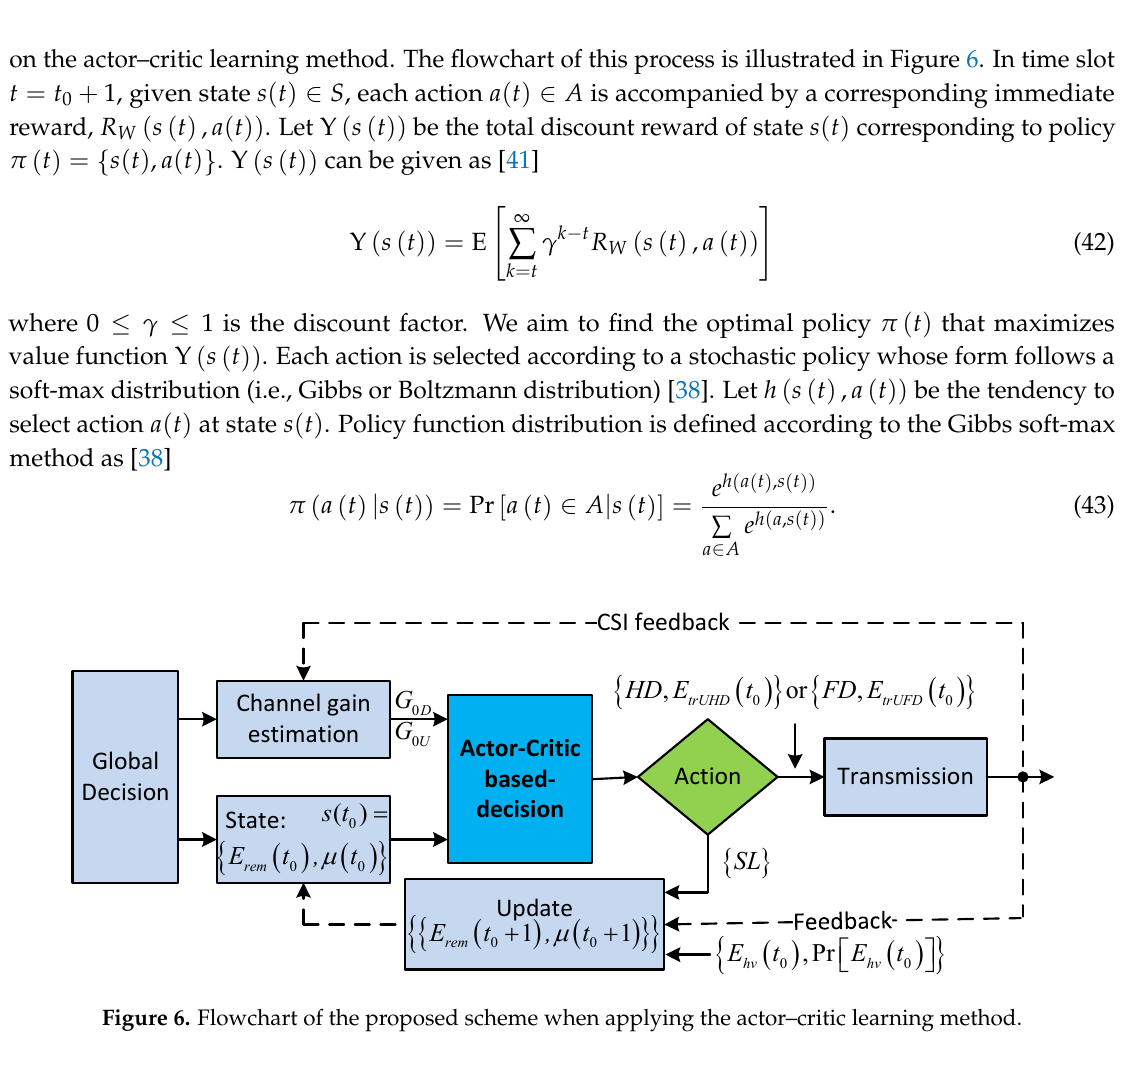
Figure 7. Actor-Critic learning process of the proposed scheme.